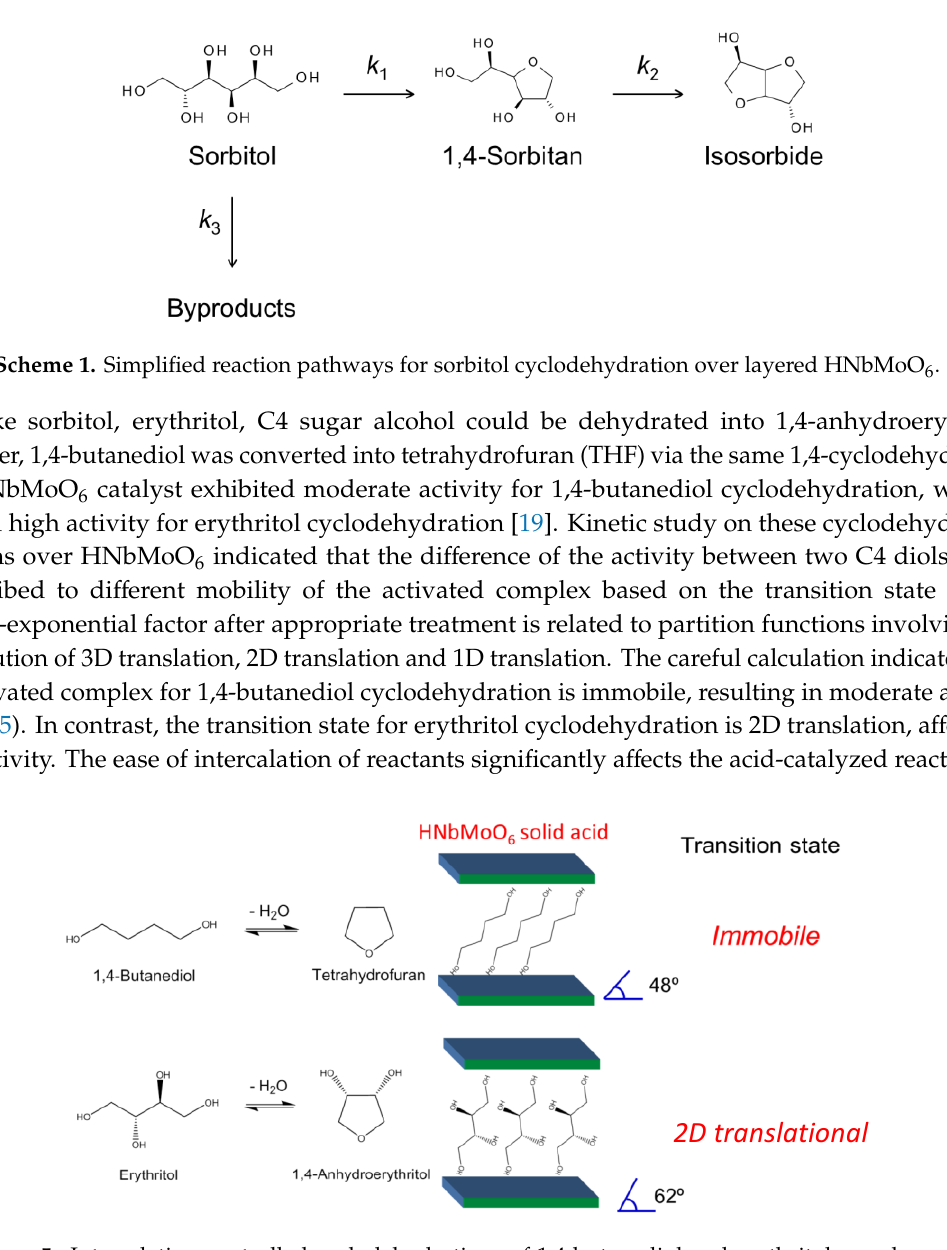
Figure 5. Intercalation-controlled cyclodehydrations of 1,4-butanediol and erythritol over layered HNbMoO 6 .